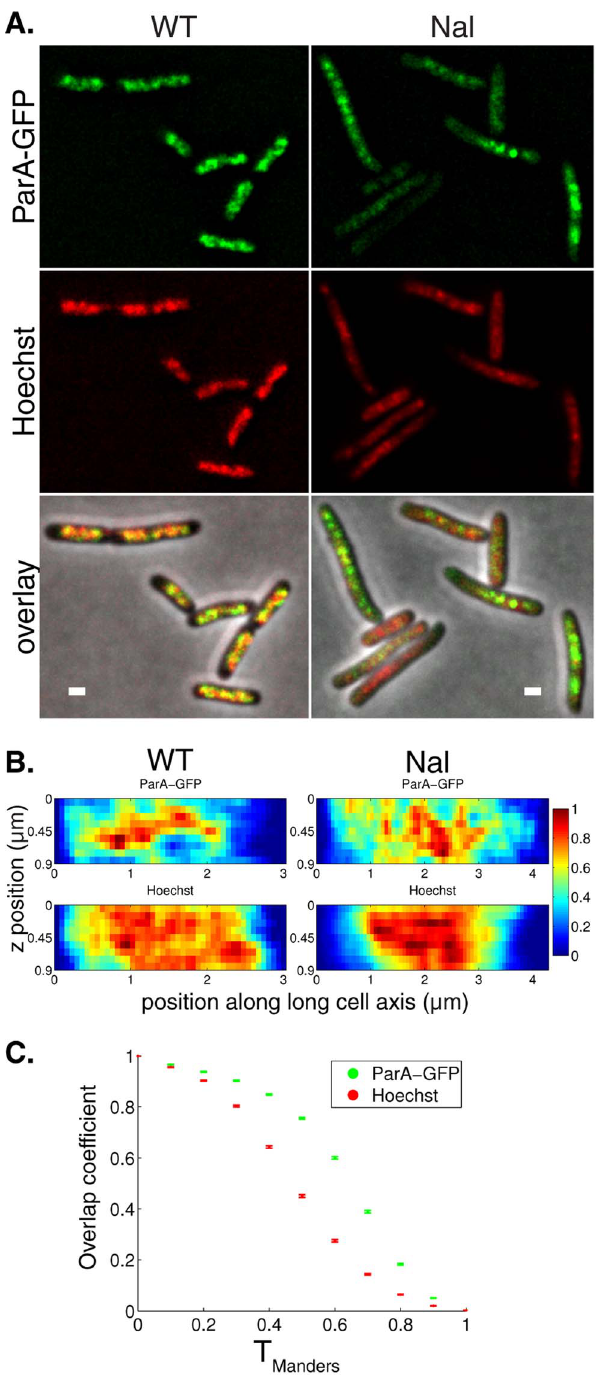
Fig. 6. ParA forms structures within the nucleoid region. ( A ) Fluorescence localization of ParA-GFP (green), Hoechst DNA stain (red) and overlay, at mid-height through cell, taken from deconvolved Z- stacks showing structures that are disrupted with 50 m g/ml nalidixic acid treatment (Nal) compared to WT. Scale bar: 1 m m; plasmid: pGE230 (mini-R1, par - , P lac ::parA::eGFP ). ( B ) Normalized fluorescence intensity profiles along the long cell axis for 9 in focus z heights (dz=0.1 m m) resulting from deconvolved Z-stacks in representative WT and Nal- treated strains. ( C ) Manders overlap coefficients in WT cells (error bars: standard error of the mean, n=678) showing the fraction of ParA-GFP fluorescence intensity that overlaps with Hoechst DNA stain when the latter is above a threshold T Manders (ParA-GFP, green) and the